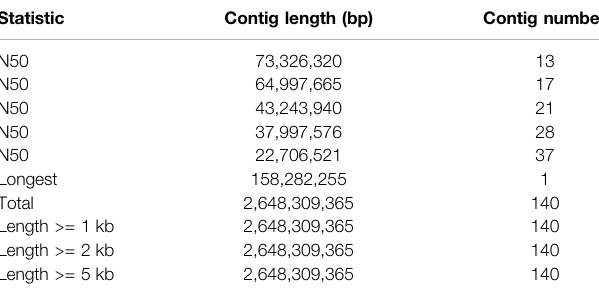
TABLE 1 | Genome assembly statistics of Dorper sheep. Statistic